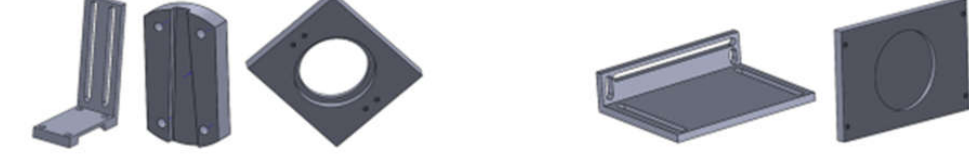
Figure 15. Virtual components of the fixing device.